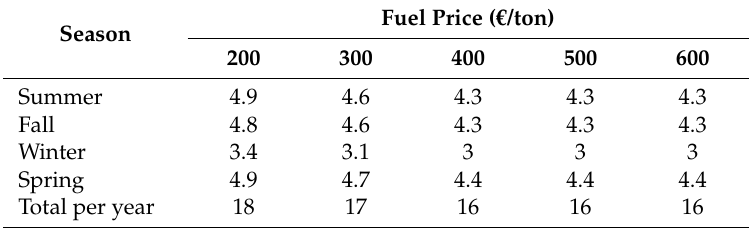
Table 42. Effect of fuel price on the optimal number of round trips for nominal freight rate.